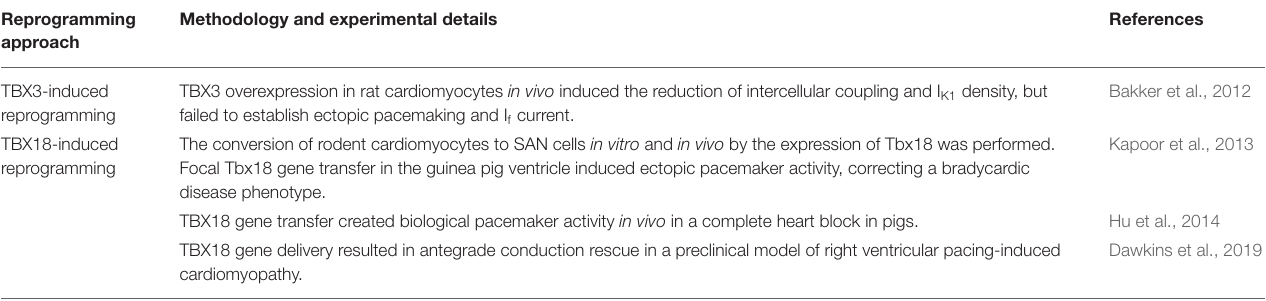
TABLE 5 | Reprogramming biopacemaking